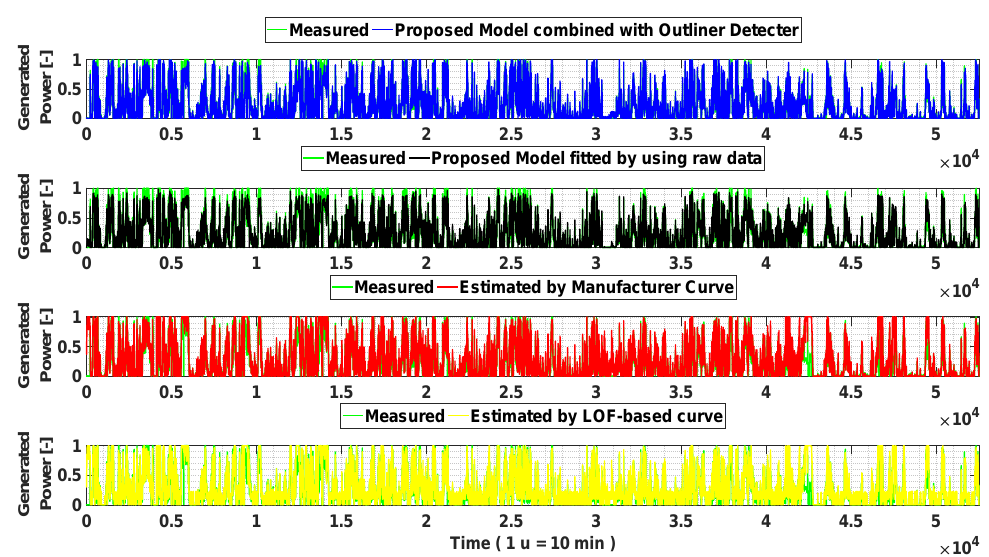
Figure 8. Annual estimated generated power profiles for each method and related comparison to measured one (green).